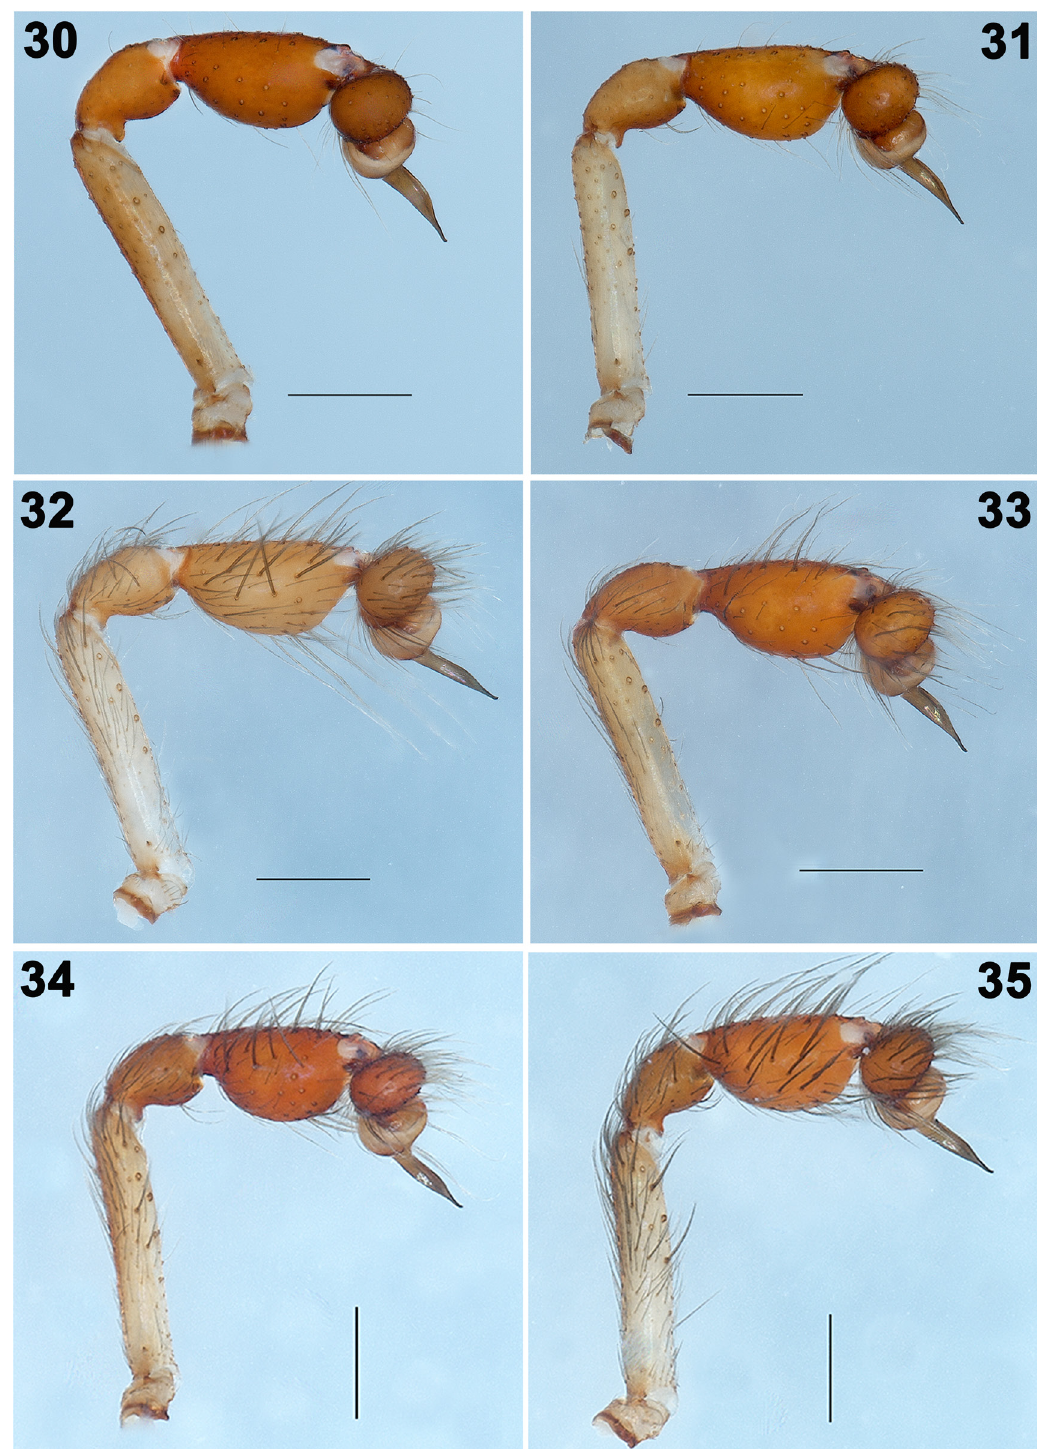
Figs 30–35. Variation of the male palps, left palps, prolateral views. 30–33 . Loxosceles tolantongo sp. nov. 30–32 . Tourist Center Grutas de Tolantongo, Municipality of Cardonal, Hidalgo (type locality). 33 . 500 m west of the entrance No. 5 to the Tourist Center Grutas de Tolantongo, Municipality of Cardonal, Hidalgo. 34–35 . Loxosceles jaca Gertsch & Ennik, 1983. 2.5 km north of Jacala de Ledezma, Municipality of Jacala de Ledezma, Hidalgo. Scale bars = 0.5